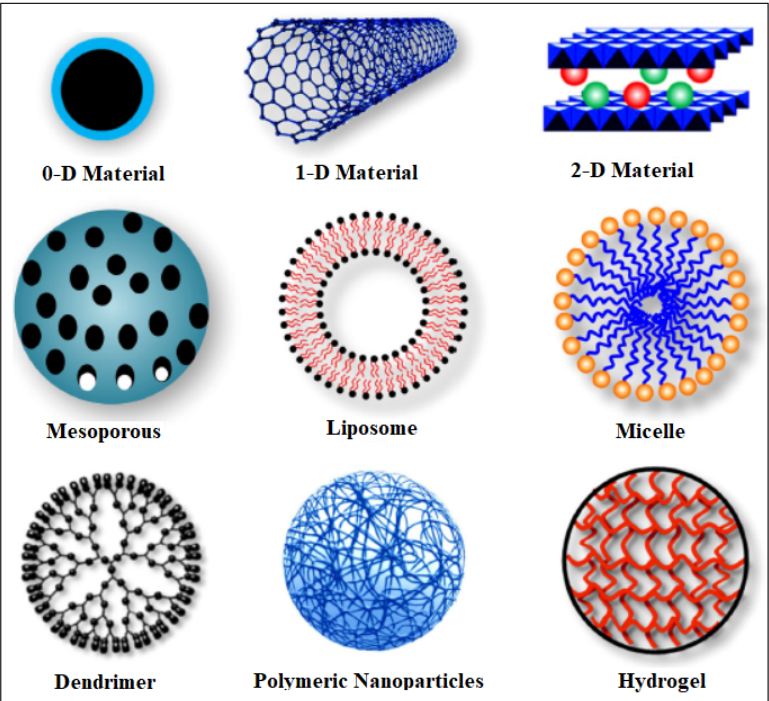
Figure 1. Different types of nanocarriers used as controlled delivery vehicles for cancer treatment. Reproduced with permission from Ref. [4]. Copyright © 2018, Nature.